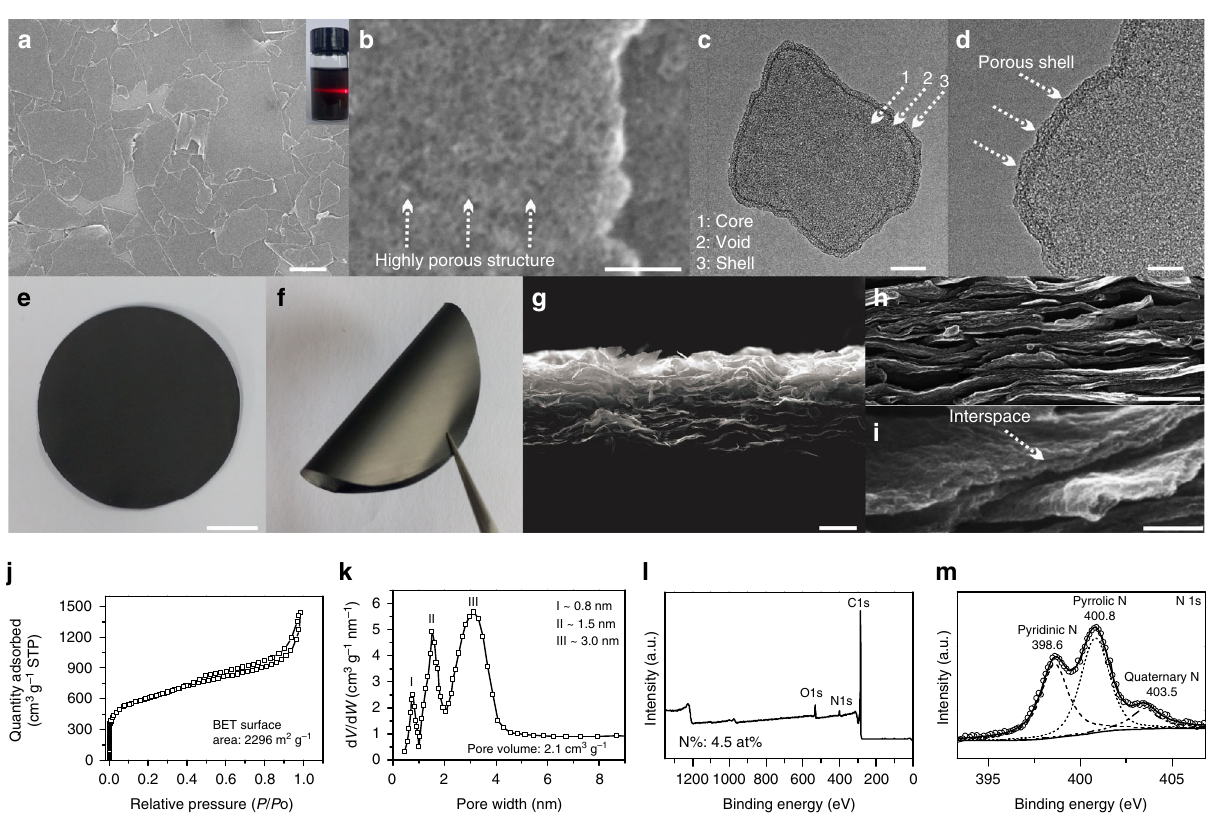
Fig. 2 Characterizations of G@HMCN. a , b SEM images and c , d TEM images of G@HMCN; e , f Optical images, and g – i cross-section SEM images of the fl exible G@HMCN paper; j N 2 sorption isotherm, k pore-size distribution, l XPS spectrum, and m N 1s XPS spectrum of G@HMCN Inset of a: optical image of the G@HMCN aqueous dispersion. Scale bars, 2 μ m a ; 50 nm b ; 100 nm c ; 50 nm d ; 1 cm e ; 5 μ m g ; 500 nm h ; 100 nm